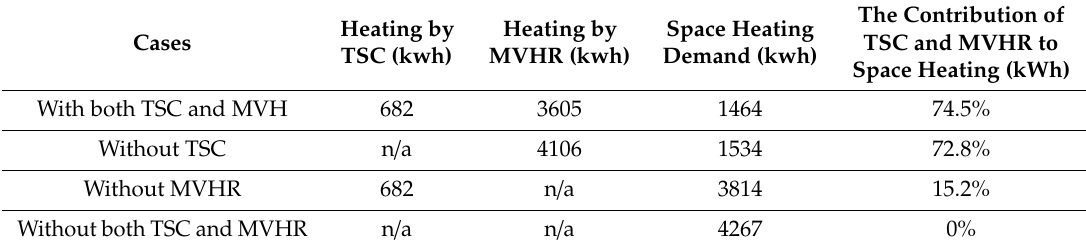
Table 9. Performance predictions of cases with and without TSC and/or MVHR.